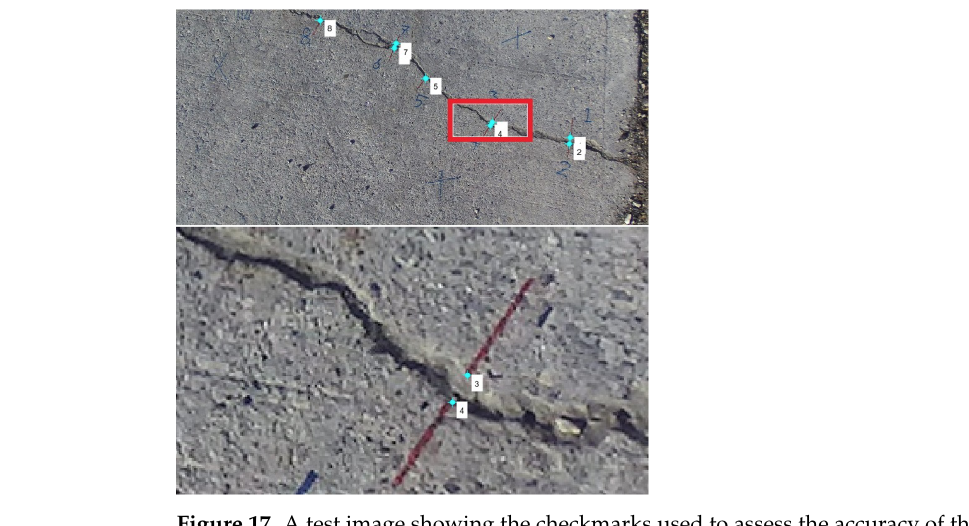
Figure 17. A test image showing the checkmarks used to assess the accuracy of the 3D reconstruction approaches. The bottom image is a zoomed-in view of the red rectangle in the top image.